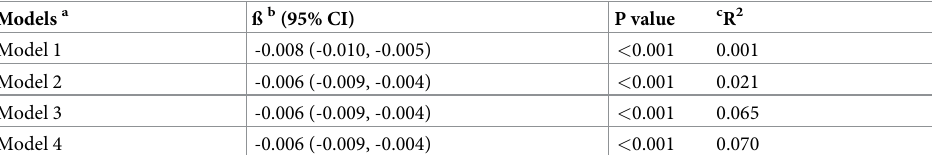
Table 2. Association between the level of vitamin D and the level of measles antibody titer. Models